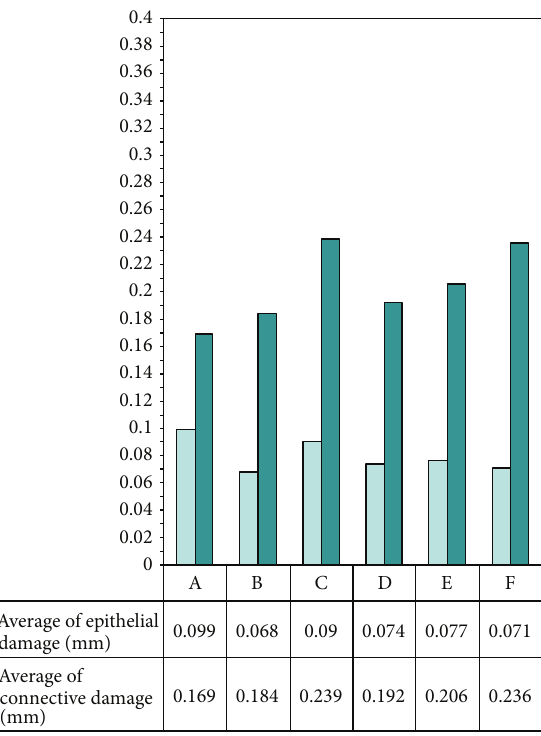
Figure9:Barchartreferringtoaveragevaluesobtainedonepithelial and